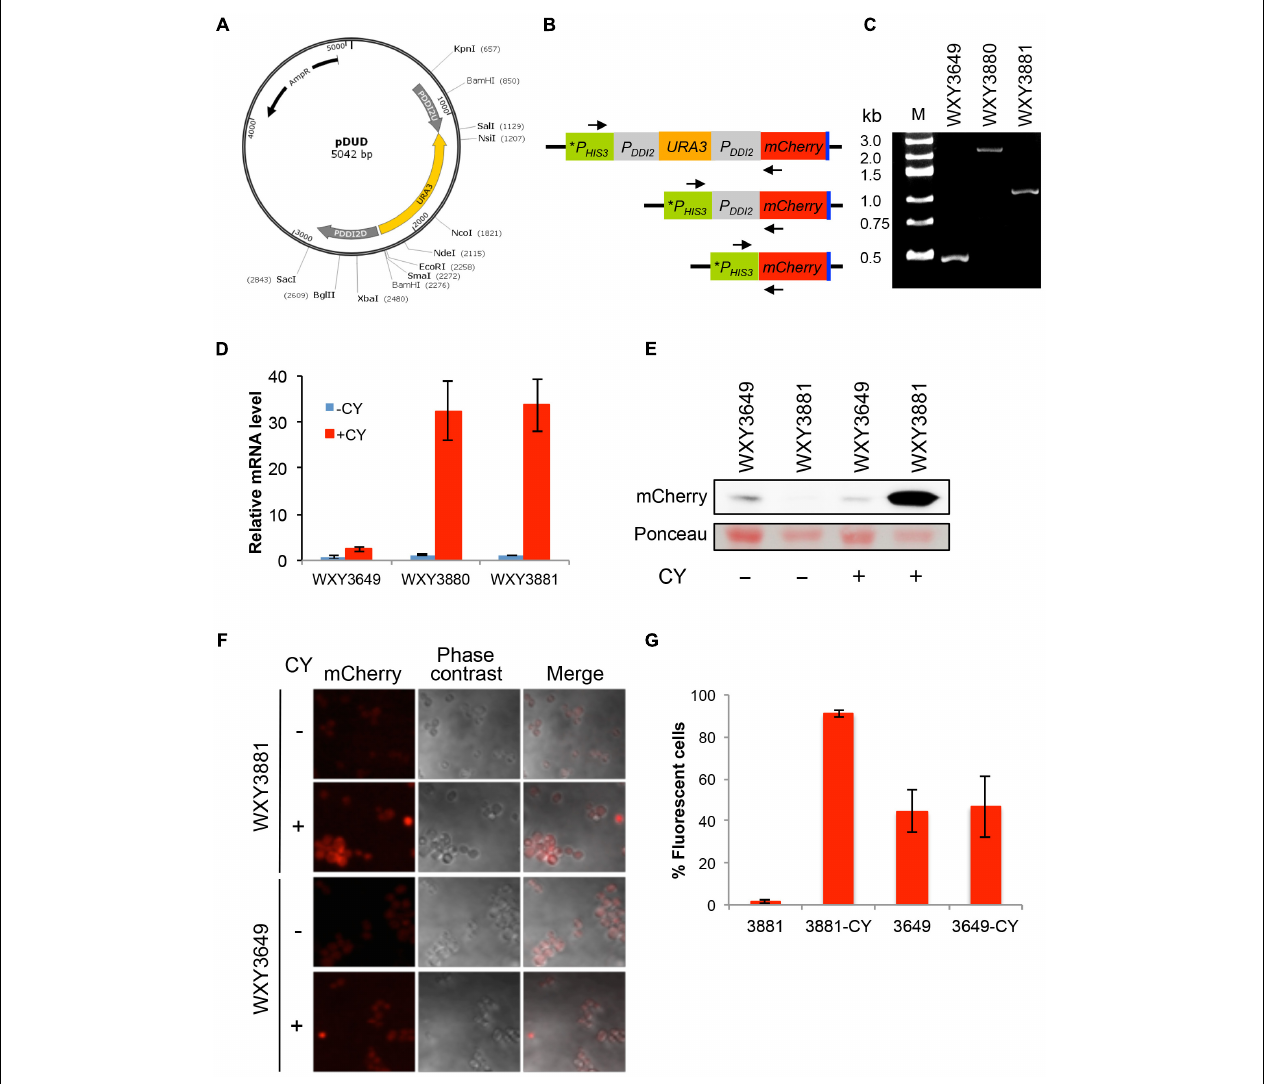
FIGURE 6 | Construction and characterization of DDI2 -based promoter shuffling. (A) The physical map of plasmid pDUD. The P DDI2 U-URA3-P DDI2 D cassette is shown in the inner circle. This cassette is used as a template to amplify a gene-specific cassette for yeast transformation. (B) Schematic diagram of pop-in and pop-out products at the P HIS3 -mCherry locus in WXY3649. Arrows indicate forward and reverse primers 5 (cid:48) -TAGGAGTCACTGCCAGGTAT-3 (cid:48) and 5 (cid:48) -TGCTTCACGTAGGCCTTGGAG-3 (cid:48) , respectively, used to perform genomic PCR to confirm the pop-in and pop-out products. (C) Agarose gel electrophoresis of genomic PCR products. Molecular size markers are indicated on the left. Predicted PCR product sizes are: WXY3649, 0.5 kb; WXY3880, 2.5 kb; WXY3881, 1.2 kb. (D) qRT-PCR analysis of mCherry expression in the pop-in (WXY3880) and pop-out (WXY3881) strains in response to 10 mM CY for 2 h. mCherry -specific primers are 5 (cid:48) -CAGACCGCCAAGCTGAAGGTGA-3 (cid:48) and 5 (cid:48) -TCCCAGCCCATGGTCTTCTTCT-3 (cid:48) . The yeast ACT1 mRNA was used as an internal control. The relative mCherry mRNA level with untreated WXY3649 cells was set as 1. The data are an average of three independent experiments with standard deviations shown as error bars. (E) Western blot analysis of mCherry-Myc levels in the pop-out strain in response to 10 mM CY treatment for 2 h using an anti-c-Myc monoclonal antibody 9E10 (Sigma, M4439). Ponceau stain was used prior to the western blot to serve as a loading control. (F) Representative images of cells with or without 5 mM CY treatment for 2 h. (G) Quantitative analysis of percentage of fluorescent cells as shown in (F)